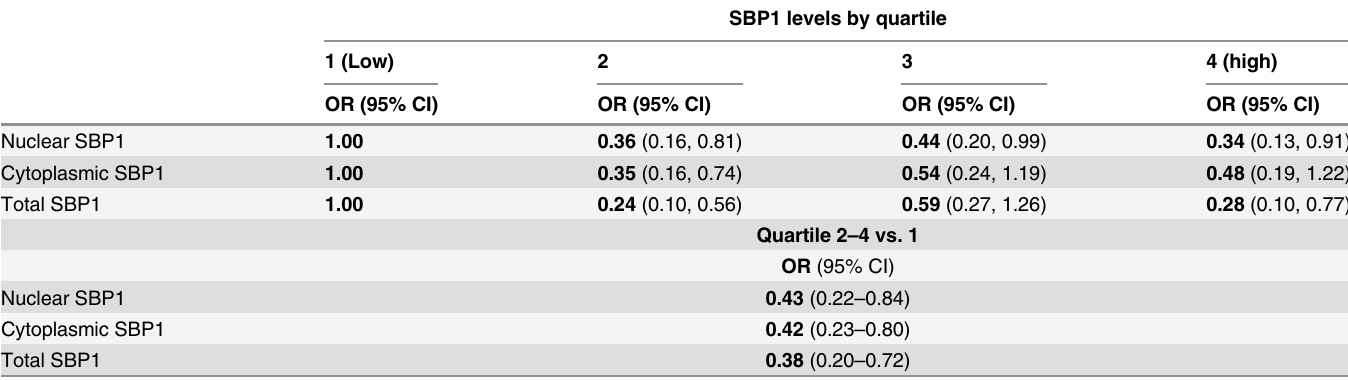
Table 1. Patients whose tissue was in the lowest quartile of nuclear SBP1 are significantly more likely to recur after radical prostatectomy than pa- tients whose tissues had higher nuclear